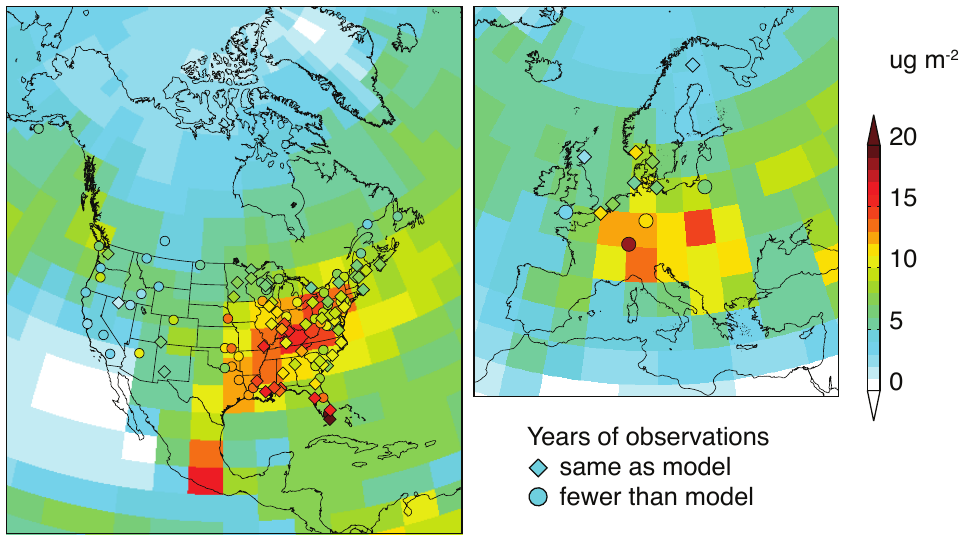
Fig. 9. Annual mercury wet deposition over North America during 2006–2008 and Europe during 2006–2007 from the Hg+Br model. Overlaid points show observations for the same years from the Mercury Deposition Network (MDN) over North America and from the European Monitoring and Evaluation Programme (EMEP) over